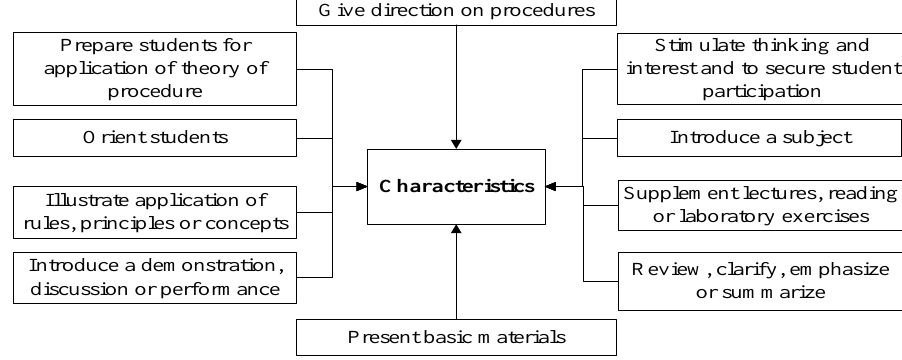
Figure 3. Proposed method